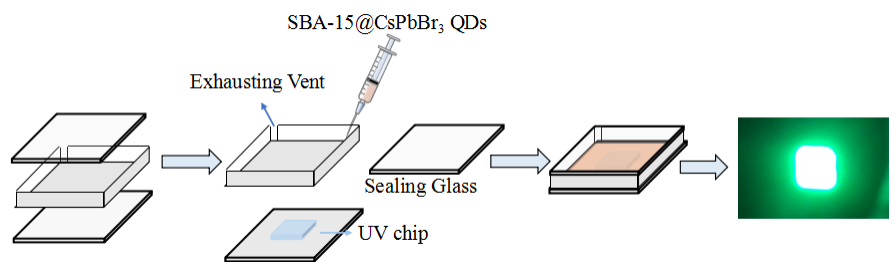
Figure 9. The process flow of liquid-type QD-LEDs and the picture of LED sample with green emission color operated at 3.2 V under a dark condition.